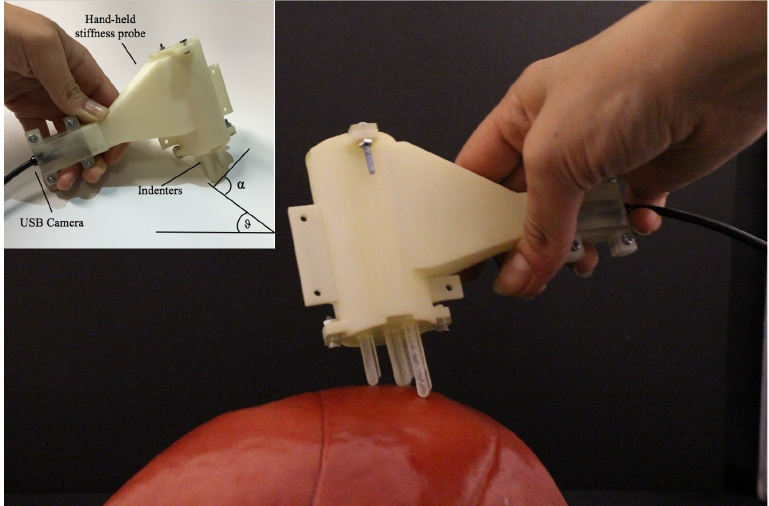
Figure 1. Multi-axis stiffness sensor interacting with a soft surface. The definition of the angles is represented in the upper left part of the